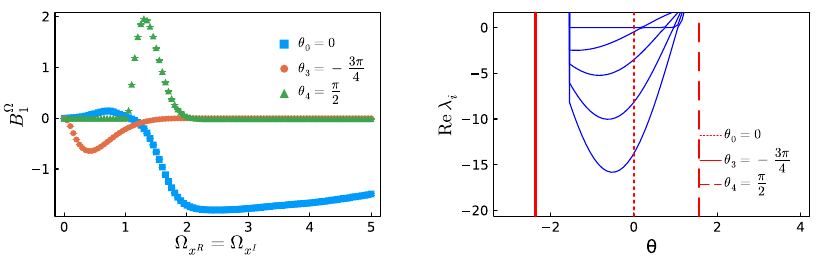
Figure 13 . (left) Boundary term according to the x 2 observable for the model of eq. (B.1) with σ = − 1+4 i and λ = 2 , evaluated for the three different kernels K i discussed in the main text. (right) the five eigenvalues of the Fokker-Planck operator with the largest real part (blue lines) plotted against the kernel parameter θ . The position of the two kernels that optimize L red